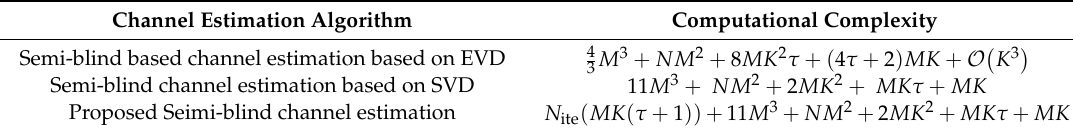
Table 1. Computational complexity